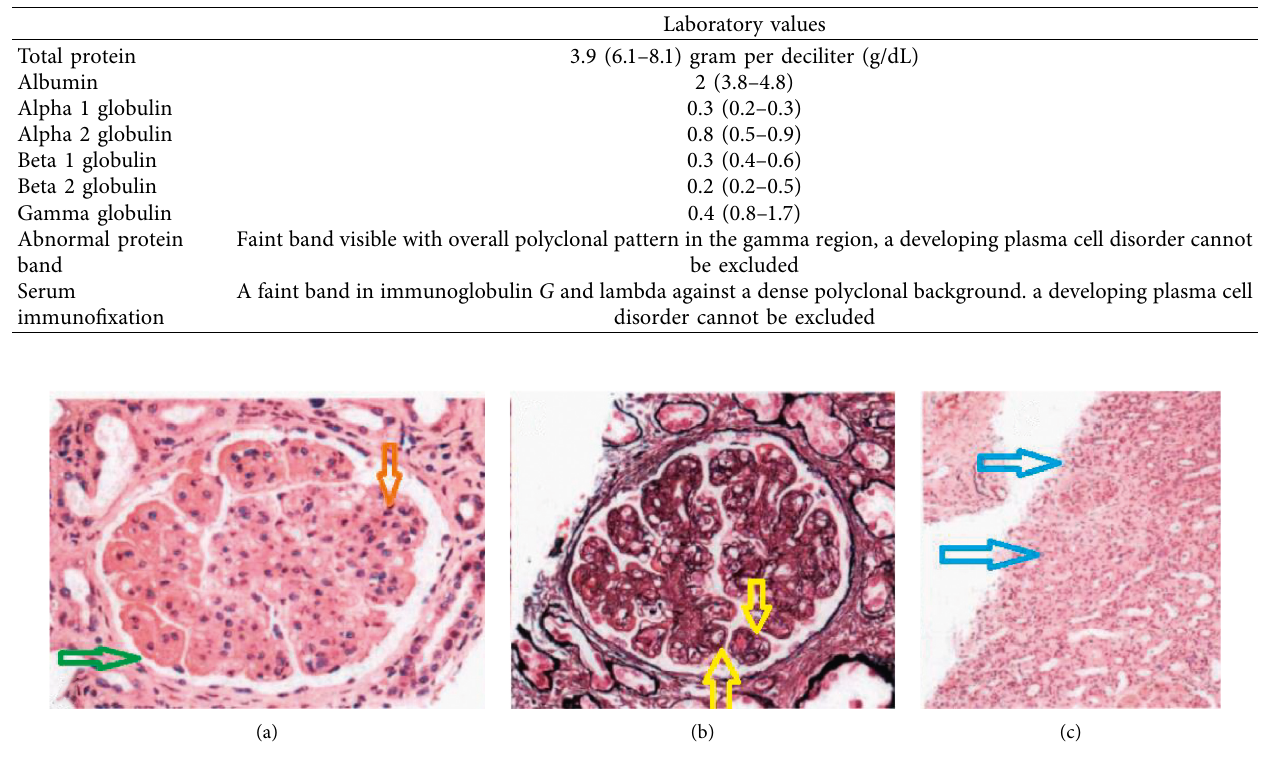
Figure 1: Image (a) showing diffuse proliferative glomerulonephritis, reduced bowman space (green arow) and increased cellularity in glomeruli (orange arow). Image (b) showing global glomerular basement membrane duplication (yellow arrow). Image (c) showing cortical scarring (blue